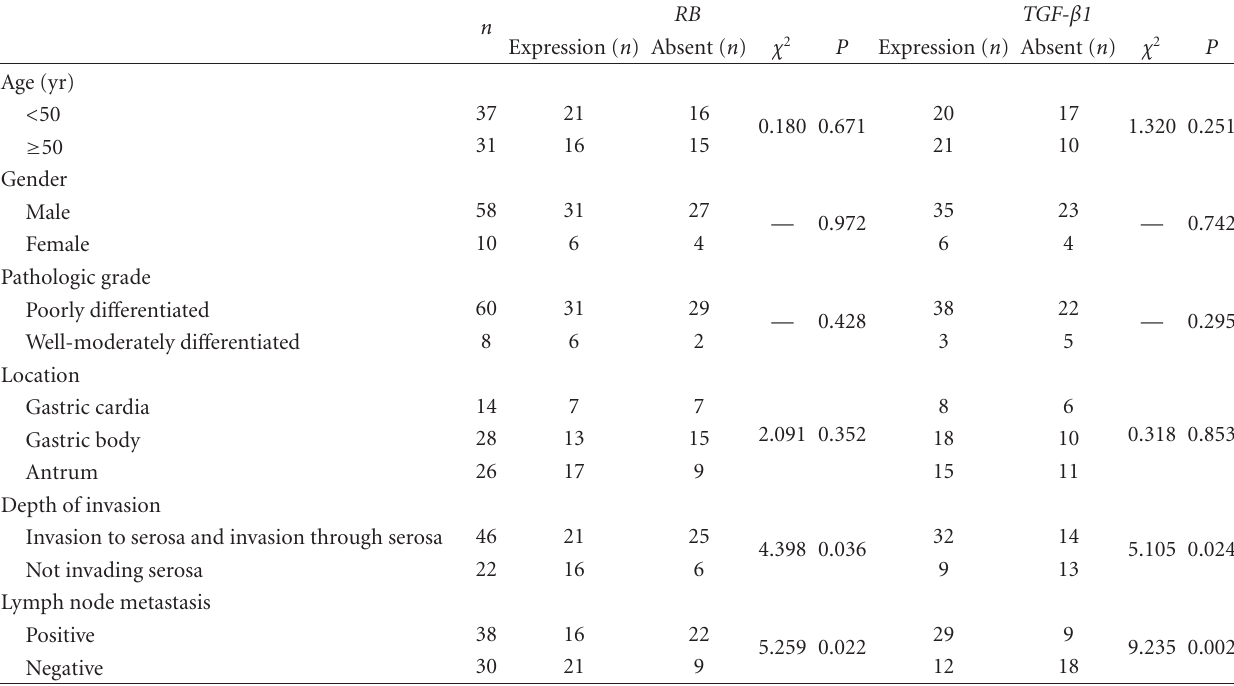
Table 6: Correlation of expression of RB an d TGF- β 1 protein with clinicopathological data of gastric carcinoma patients.